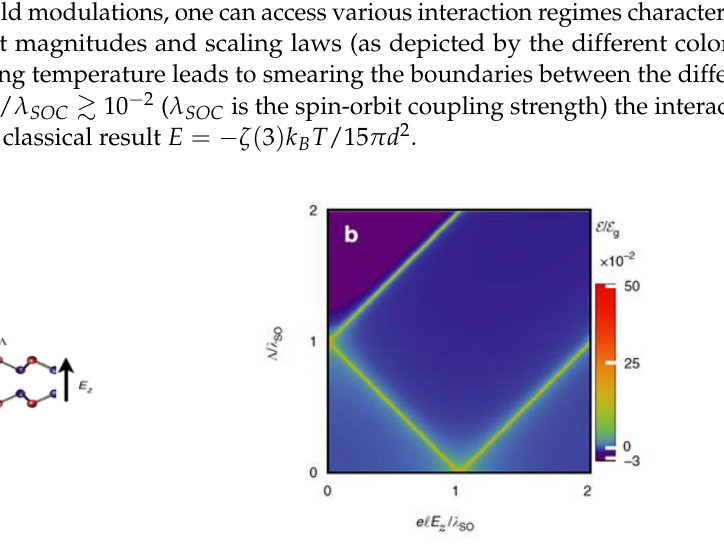
Figure 2. ( a ) Fabry–Perot cavity of two graphene-like materials under an external electric field E z and laser light Λ ; ( b ) Casimir force phase diagram of two identical dissipationless graphene-like materials with d λ SO (cid:125) = 1 . (Figure taken from reference [42])